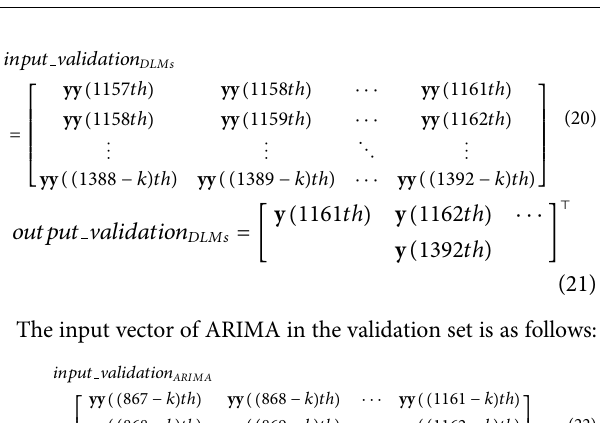
FIGURE 1 | Flowchart of the proposed ensemble forecasting system (including data preprocessing, sub-model forecasting, and ensemble forecasting based on MOGOA).